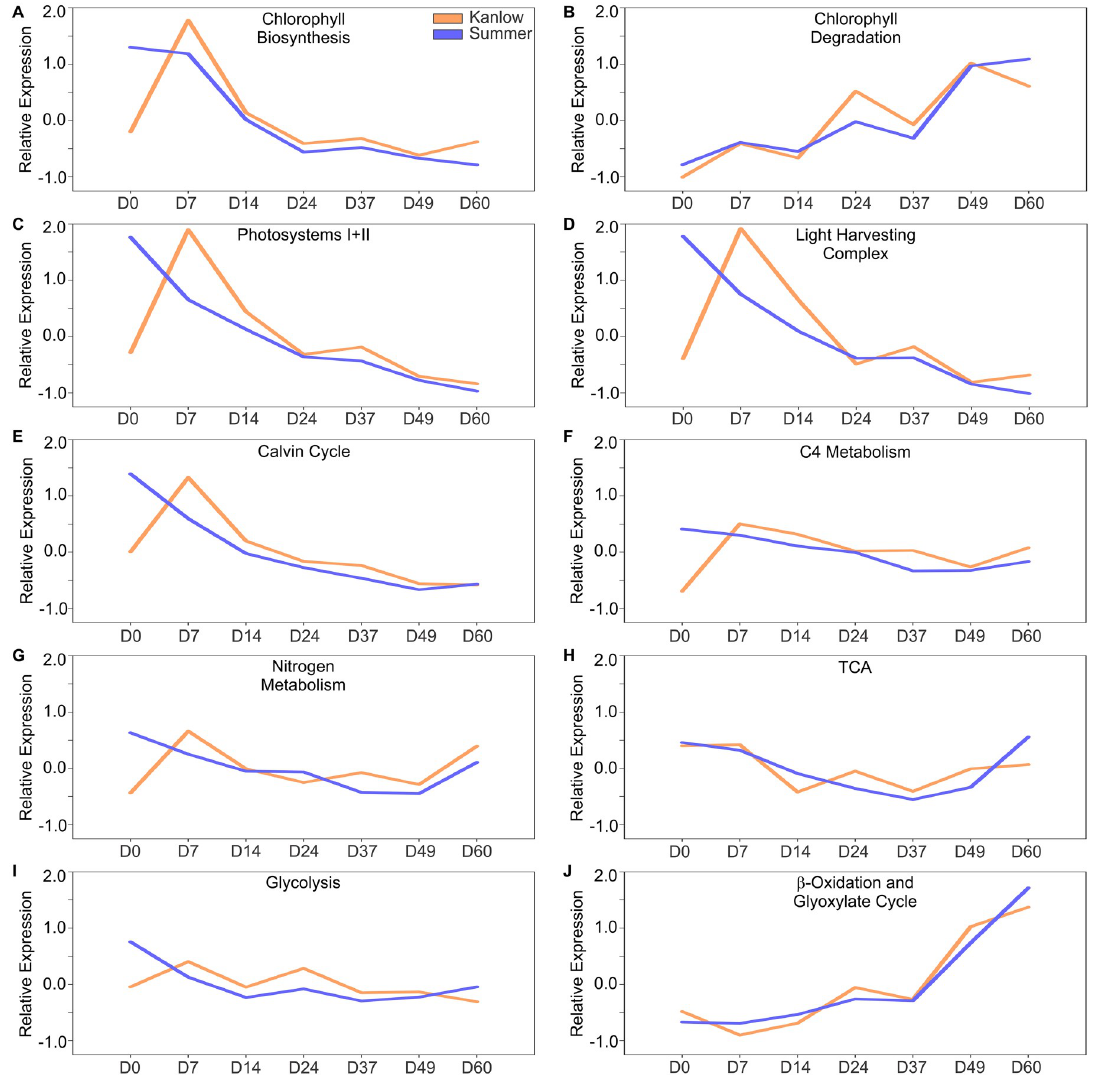
Fig 3. Expression of profiles of genes associated with central aspects of leaf function and metabolism. (A) chlorophyll biosynthesis, (B) chlorophyll degradation, (C) photosystems, (D) light harvesting complex, (E) Calvin cycle, (F) C4-metabolism, (G) nitrogen metabolism (H) TCA, (I) glycolysis, and (J) β -oxidation and glyoxylate cycle in Kanlow (orange lines) and Summer (blue lines). Both differentially expressed and non-differentially expressed transcripts from genes with at least 100 normalized counts at one time point were included. Paralogous genes with low counts were excluded in these analyses. Counts for individual transcripts were converted to z- scores and averaged for each time point.